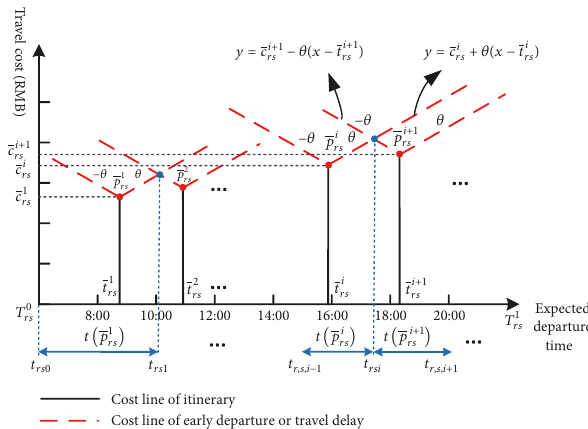
𝑖 ) of 𝑡(𝑝 𝑖+1 ) 𝑟𝑠 𝑟𝑠